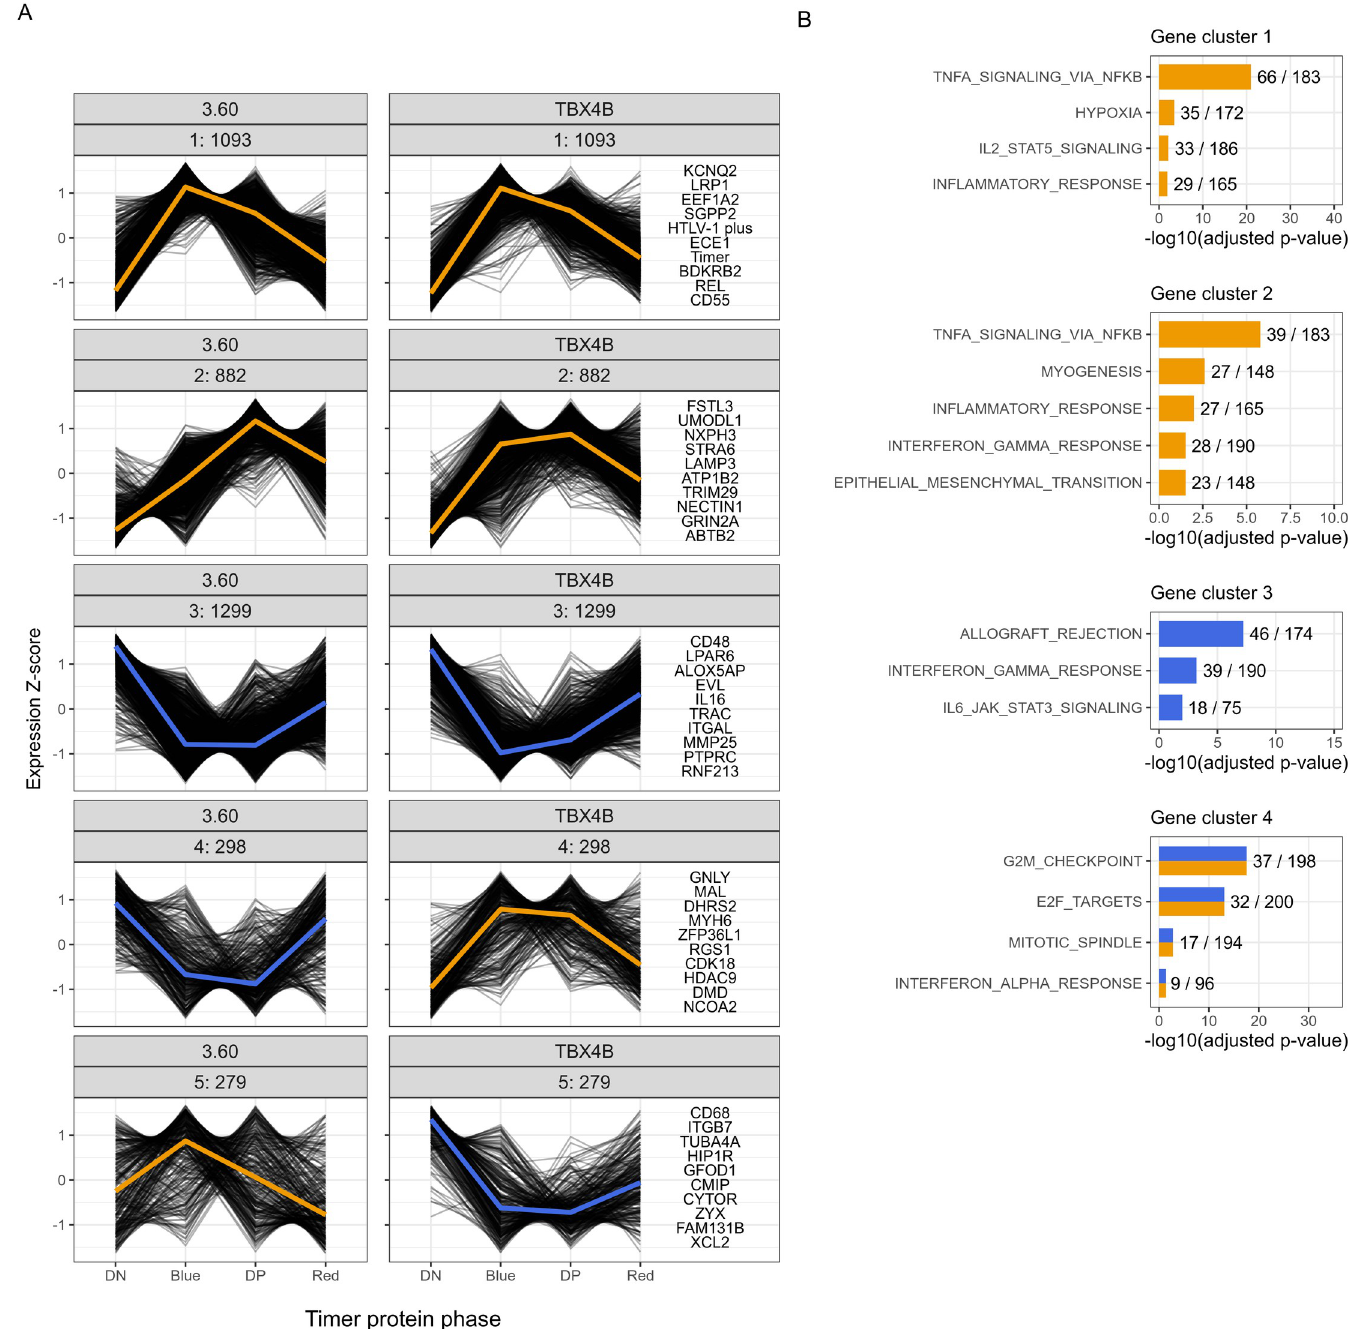
Fig 3. Genes deregulated in both clones separate into clone-independent and clone-specific clusters. (A) K-means clustering of 3851 shared significantly DE genes. Statistical significance was determined by LRT. FDR-corrected p-value < 0.01. The top 10 genes in each cluster, based on mean rank of sorted p-values, are listed on the right of the panel. The mean expression trajectory is coloured as a yellow or blue line representing upregulation and downregulation, respectively. (B) ORA of K-means clusters with the Hallmarks gene set from The Molecular Signatures Database (MSigDB). Statistical significance was determined by Fisher’s exact test in g:Profiler. FDR- corrected p-value <